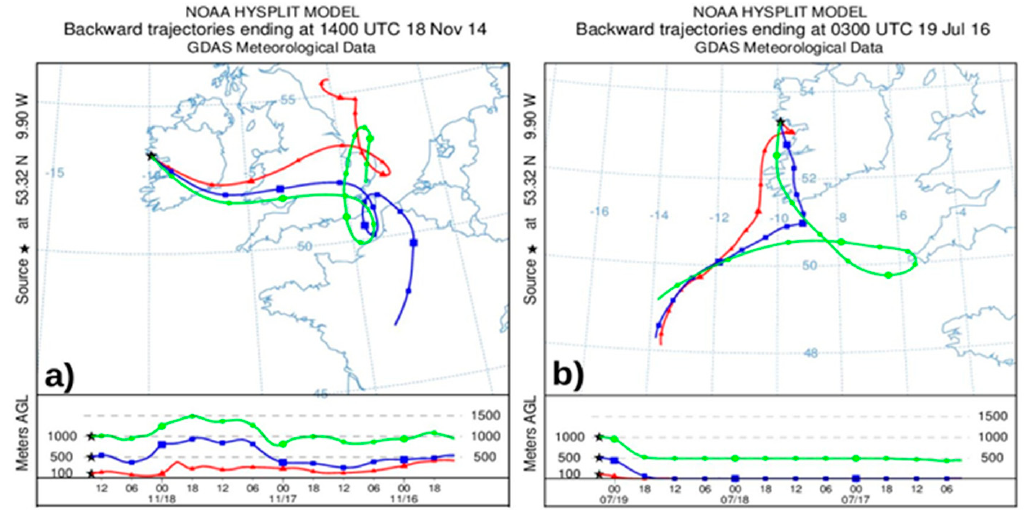
Figure 5. HYSPLIT backward trajectories run over 72 h for CALIOP’s overpasses at Mace Head on ( a ) Cloud–free case (18/11/14) at 13:41:22 UTC. ( b ) Thin cloud case (19/07/16) at 03:11:35.